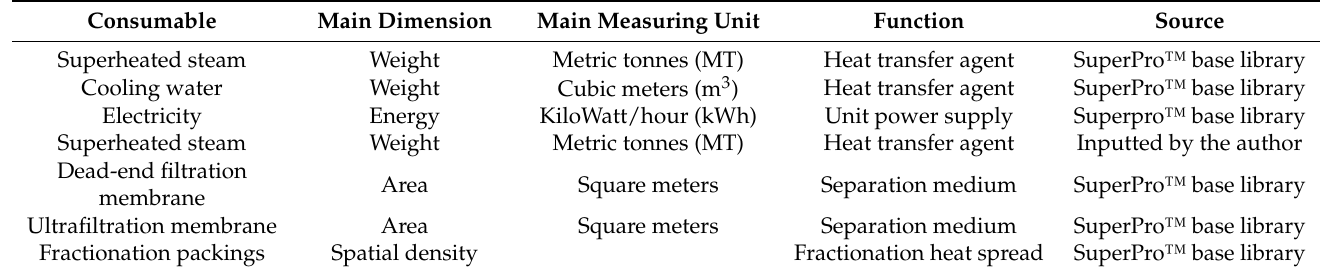
Table 6. The consumables within a single